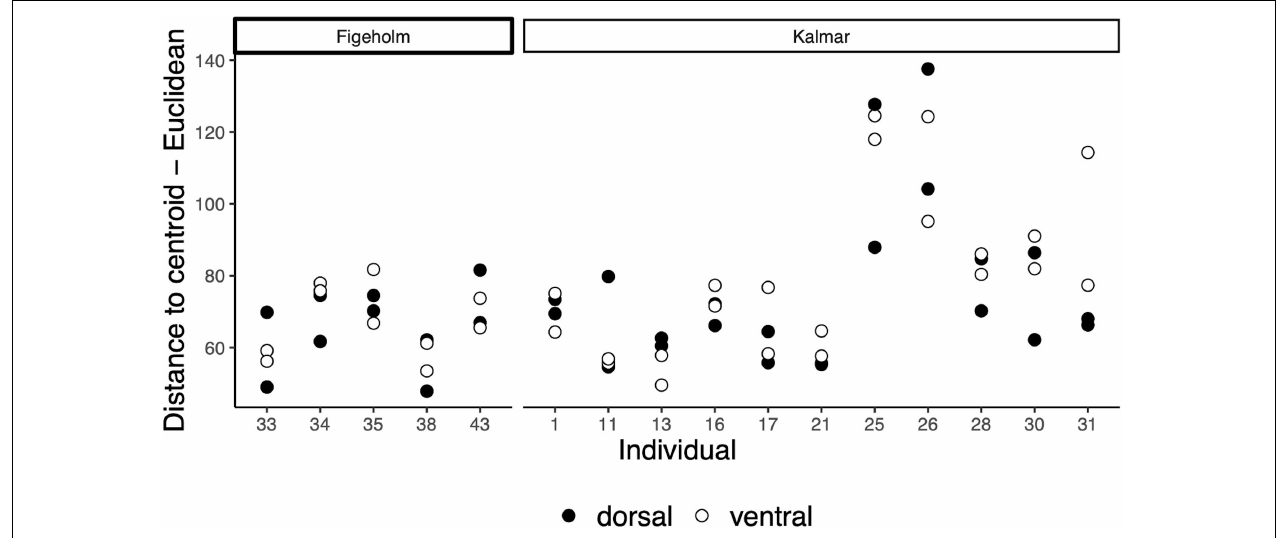
FIGURE 2 | Variance among replicate samples of fish skin microbiomes from dorsal and ventral body sites within different host individuals. Beta dispersion plots based on Euclidean distances to centroid. Each dot represents one sample and shows the dispersion among the four samples taken from mirroring left and right sides of the dorsal and ventral body sites from each fish individual ( n = 16) collected from Figeholm and